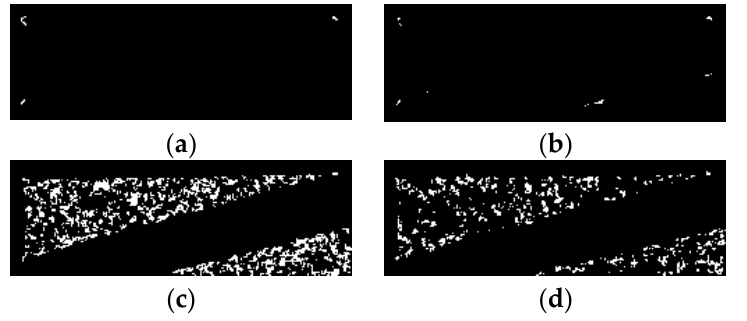
Figure 11. Results of corner detection before and after median filtering and sharpening. ( a ) corner detection before median filtering and sharpening, no noise. ( b ) corner detection after median filtering and sharpening, no noise. ( c ) corner detection before median filtering and sharpening, σ = 0.05. ( d ) corner detection after median filtering & sharpening, σ = 0.05. Under the condition of white noise with mean µ = 0 and variance σ = 0.05 applied to the image, the corner points, processed by the expansion + erosion method, were more clearly as shown in Figure 10c,d. The corner points processed by the median filtering + sharpening method had the situation that the contour corner points in the region of interest were mistakenly deleted, and the error was larger, as shown in Figure 11b. Four error indicators E mae , E mse , σ 5 , and σ 10 , were selected for the quantitative analysis of the identification before and after treatment with the expansion + corrosion